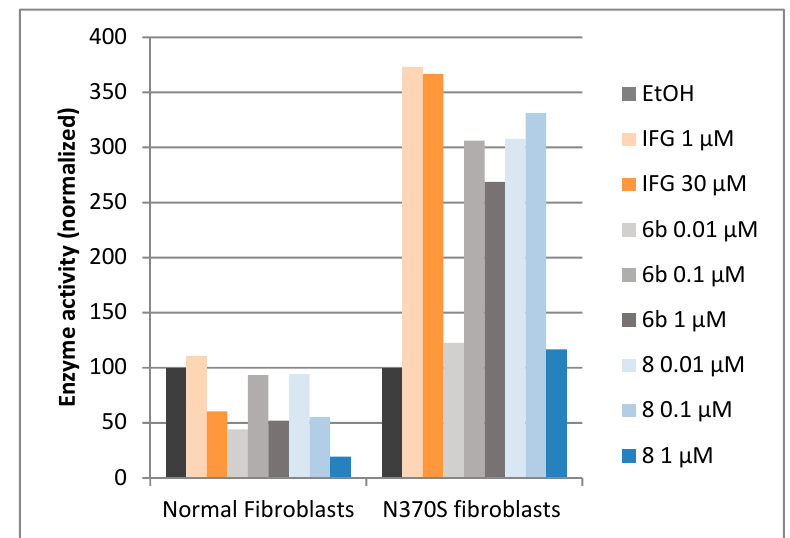
Figure 6. Effect of IFG, 6b and 8 on lysosomal GBA activity in N370S fibroblasts (Gaucher disease type 1) after 72 h. In the absence of added compounds, the GBA activity in N370S fibroblasts averaged 6.4 nmol/h · mg while that in normal fibroblasts it approximated 43.0 nmol/h ·